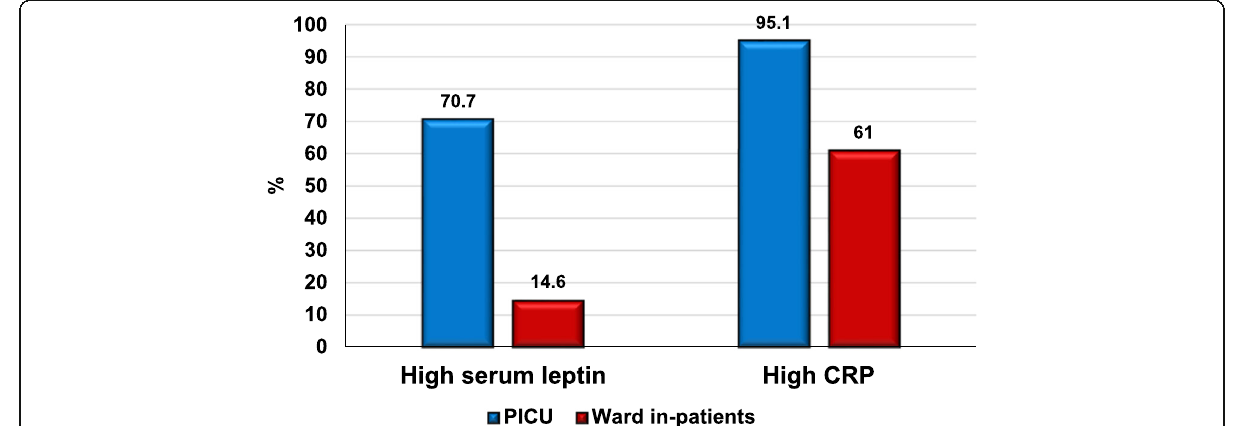
Fig. 1 Relative frequency of patients with high serum leptin and CRP in the studied